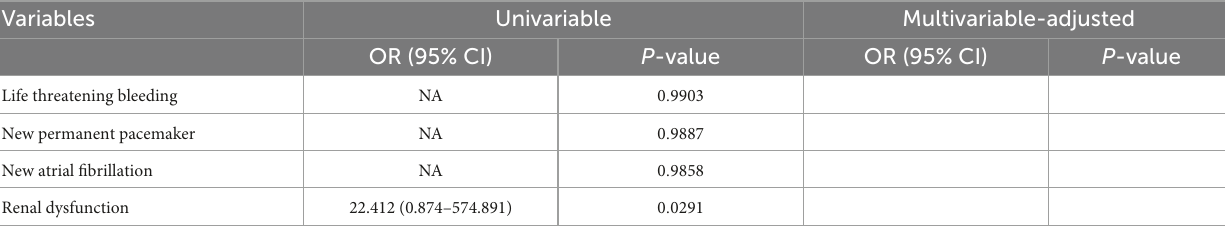
with NT-proBNP trajectory class 2 (HR 1.90, 95% CI 1.03–3.52, P = 0.04) and trajectory class 3 (HR 5.70, 95% CI